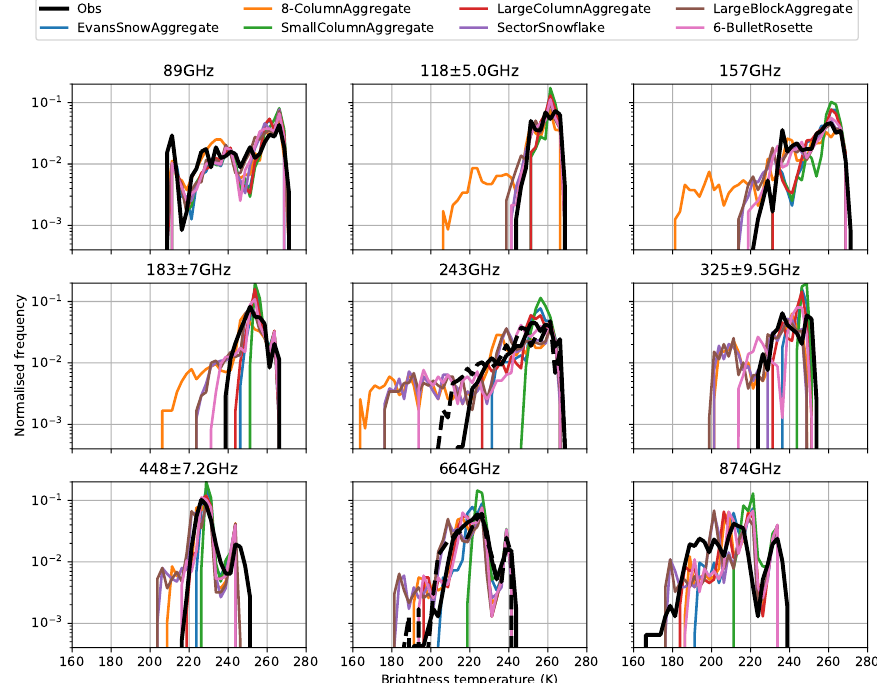
Figure 8. Brightness temperature histograms for observations and simulations using different ice particle habits for selected channels. The dashed black lines at 243 and 664 GHz represent the horizontally-polarised observations, and the solid black lines represent the vertically-polarised observations. Results for other channels can be found in Figure S11 in the Supplement.